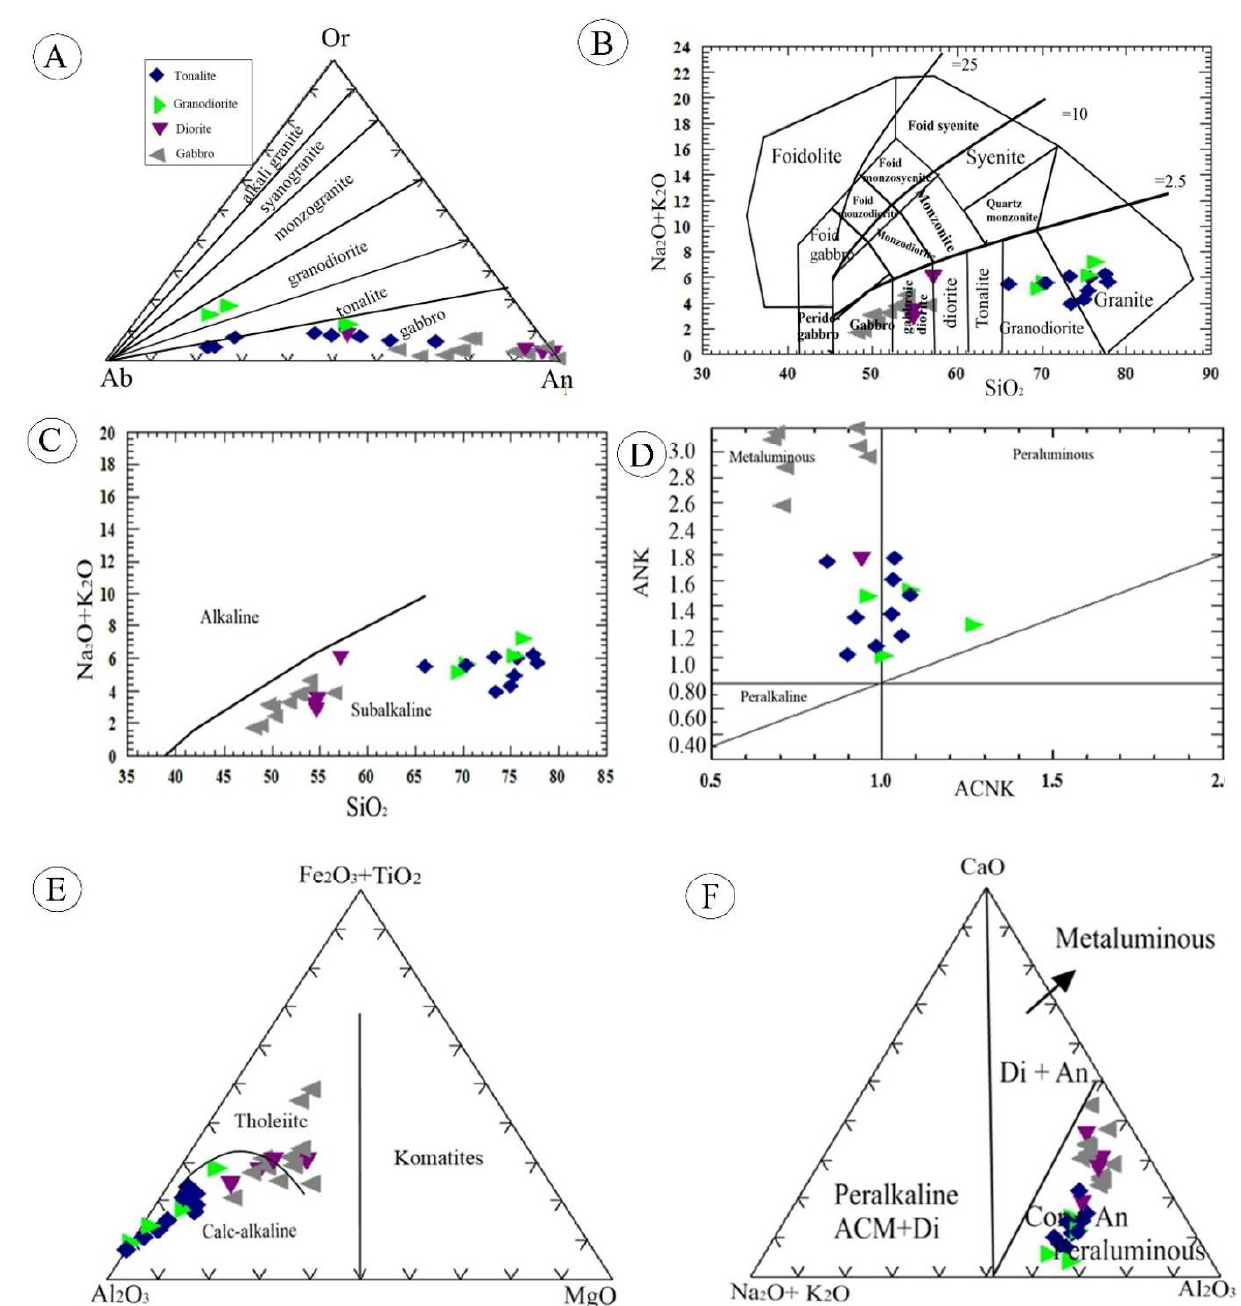
Figure 5. ( A ) Geochemical classification of the studied rocks of [51] based on the Ab–Or–An ternary diagram. ( B ) Chemical nomenclature of plutonic rocks using TAS diagram [57]. ( C ) Total alkali–silica variation diagram (Irvine and Baragar, 1971). ( D ) CNK variation diagram of the studied samples [53]. ( E ) (Fe 2 O 3 + TiO 2 )—Al 2 O 3 -MgO diagram for the studied rocks [54]. ( F ) CaO-Na 2 O + K 2 O-Al 2 O 3 diagram [58]. Symbols as in (Figure 5A).